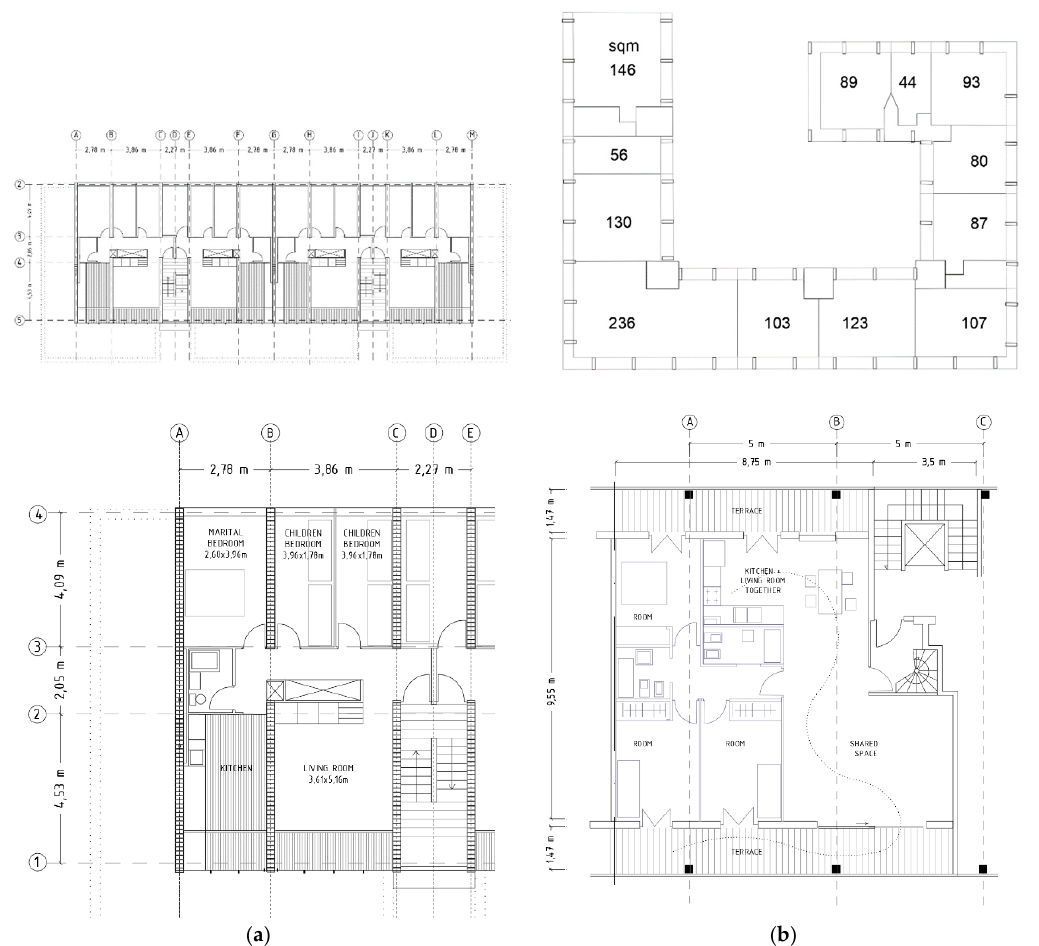
Figure 1. ( a ) Example of spatial segregation in collective social housing in the “Poblado Dirigido de Fuencarral,” Madrid, 1956 Block housing scale and “dwelling type.” The kitchen and the living room are in two separate spaces, separated by load-bearing walls. The person working in the kitchen is isolated and the work is invisible. Source: Redrawn by De Jorge-Huertas (2015); ( b ) Example of spatial flexibility and adaptability in collective housing in the case study of 1975 (12 different dwellings per floor plan) and one of the dwelling variations in detail. The numbers show the different size of the dwellings. In the detail of one dwelling, the kitchen and living room are located together, they are not separated as in the case of Figure 1. Domestic workload in the kitchen can be seen and shared. It is not (so) invisible. Source: Redrawn by De Jorge-Huertas 2020.